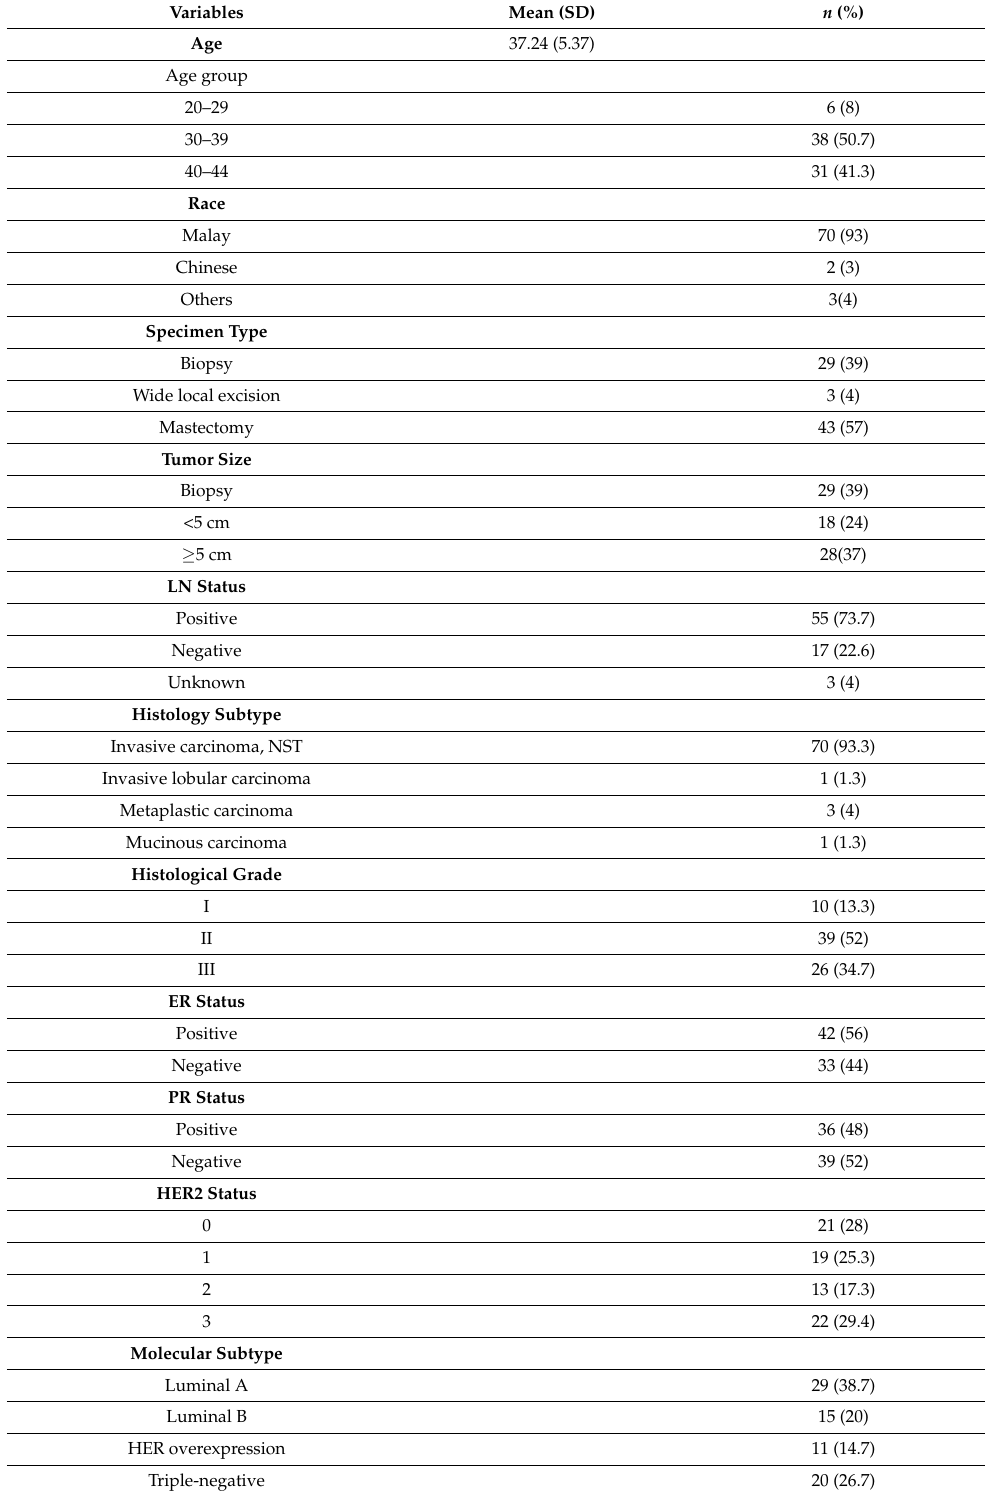
Table 2. Clinicopathological characteristics of the patients ( n =